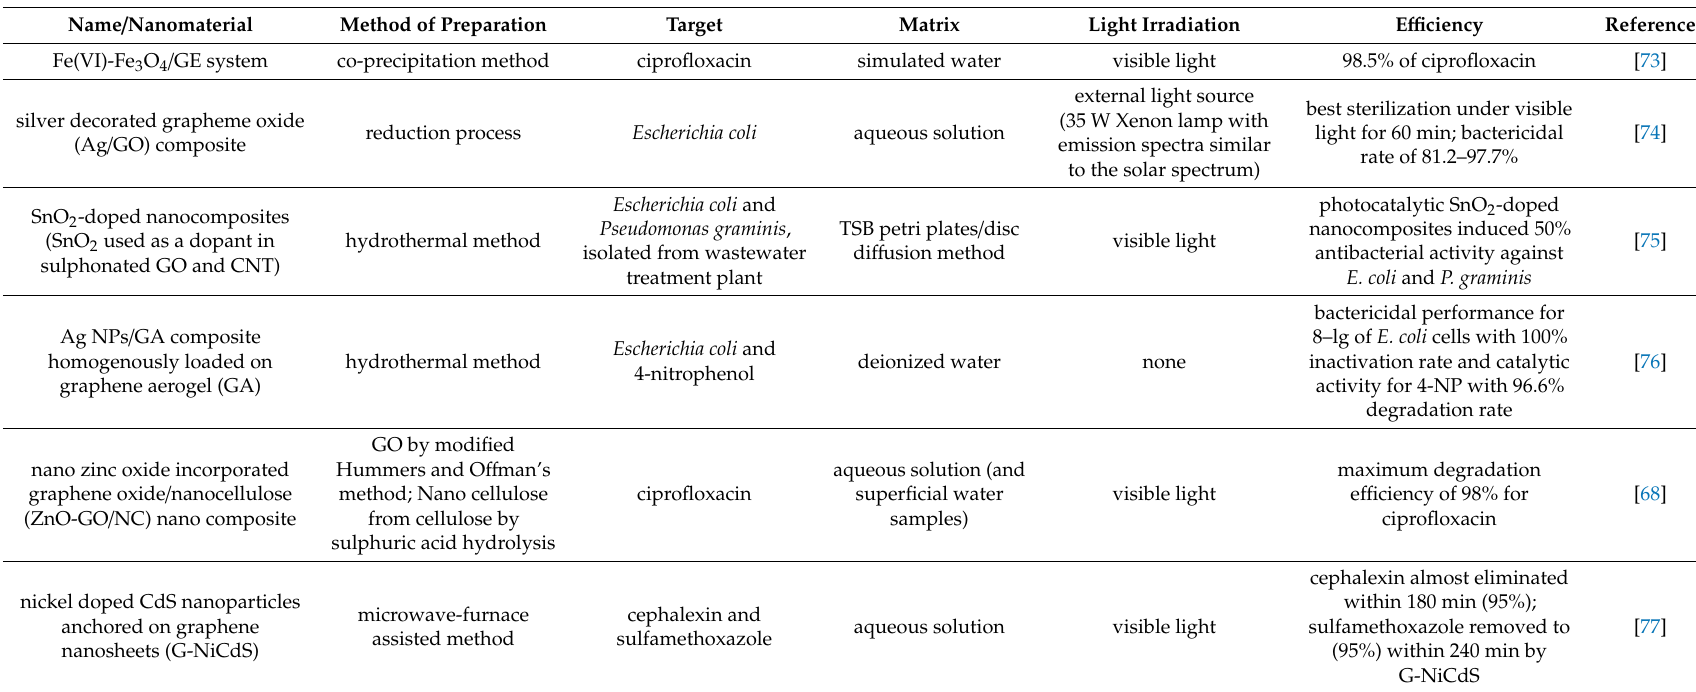
Table 2. Selected publications on graphene based composites for the treatment of emerging water micropollutants and